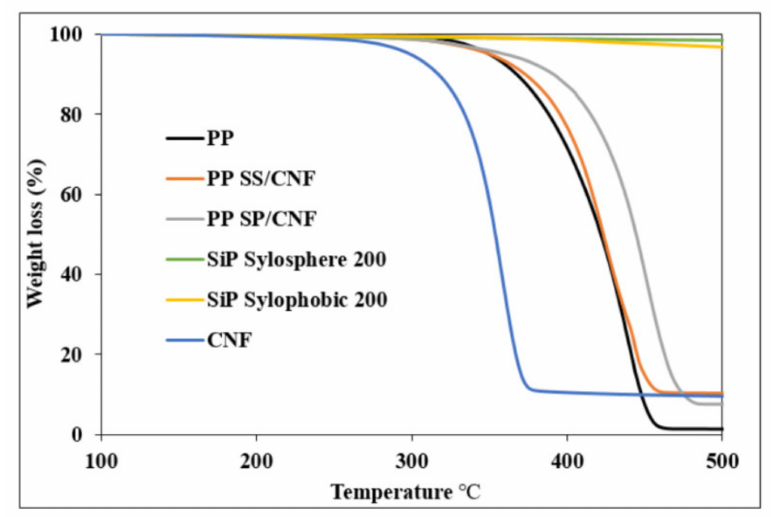
Figure 10. TGA curves of PP, SiP, CNF, PP SS/CNF, and PP SP/CNF. Compared to the neat PP, the decomposition temperature of the PP composite in- creased significantly with the addition of hybrid filler, indicating that SiPs hindered thermal decomposition of PP composite. The degradation depends on the particle encapsulation and extent of interaction with matrix. Improvement in the thermal stability of PP compos- ites was posited to be due to the excellent dispersion of the hybrid filler in the polymer matrix. Due to the stable thermal properties of the hybrid filler, chain scission process occurred at a higher temperature compared to pristine PP polymer [39]. Additionally, the weight residue at 500 ◦ C of the PP composite showed the highest for sample PP SS/CNF at 10.28% residue, followed by CNF at 9.54% residue, and PP SP/CNF at 7.53% residue. The char yield increase after melt-blending with filler is attributed to the increased interactions between the filler and the matrix which resulted in the onset of thermal degradation. Additionally, the DTA curves of the discussed composite PP SS/CNF and PP SP/CNF show that during their decomposition, endothermic reactions occurred (Figure 11). The DTA curve exhibited two endothermic events. The first is attributed to Tm at around 161 ◦ C , corresponding to the melting of the crystalline phase in the studied polymer (PP). Other endothermic peaks were observed with decomposition maxima at 428 and 450 ◦ C in higher temperature ranges. The thermal decomposition of PP SP/CNF is higher than PP